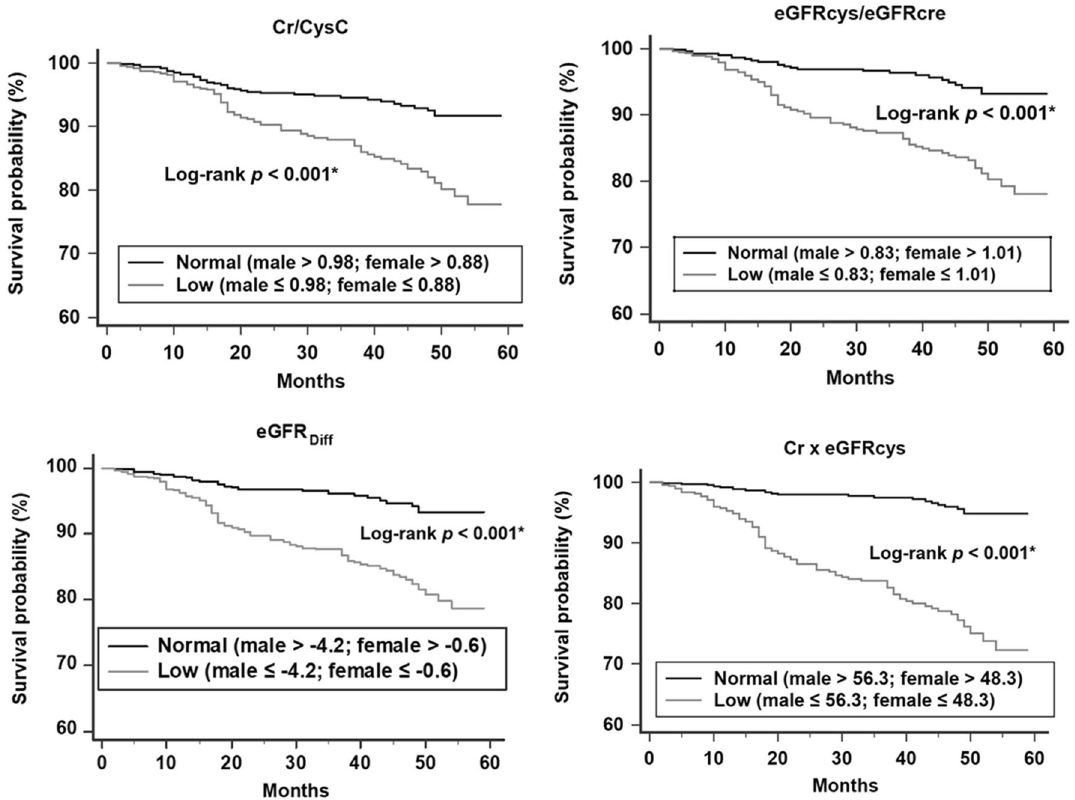
Figure 2. Kaplan–Meier survival analysis of study population with normal or low sarcopenia